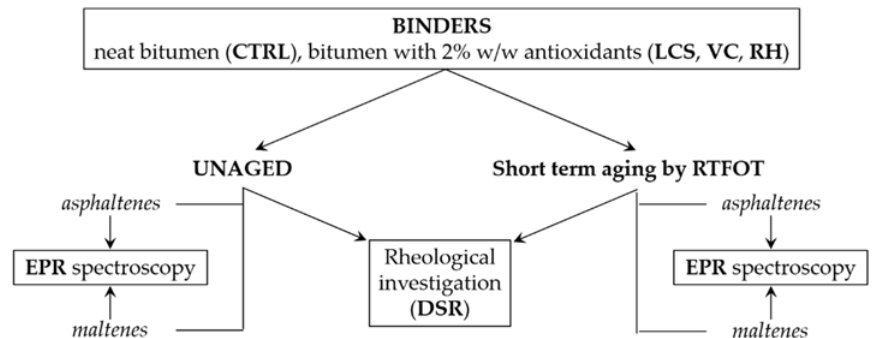
Figure 1. Flowchart of the experimental approach. The tested binders both neat bitumen as control CTRL, and bitumen modified with 2% w / w of natural antioxidants, namely, a mix of phospholipids (LCS), Vitamin C (VC) and rice husk (RH), are subjected to artificial thermal treatment by Rolling Thin Film Oven Test (RTFOT). Then, Dynamic Shear Rheological (DSR) tests carried out on artificially aged binders are compared to those performed on aliquots of unaged samples. A parallel EPR study is performed on both the asphaltene and maltene fractions obtained, respectively, from unaged binders and bitumens subjected to short-term aging by RTFOT.